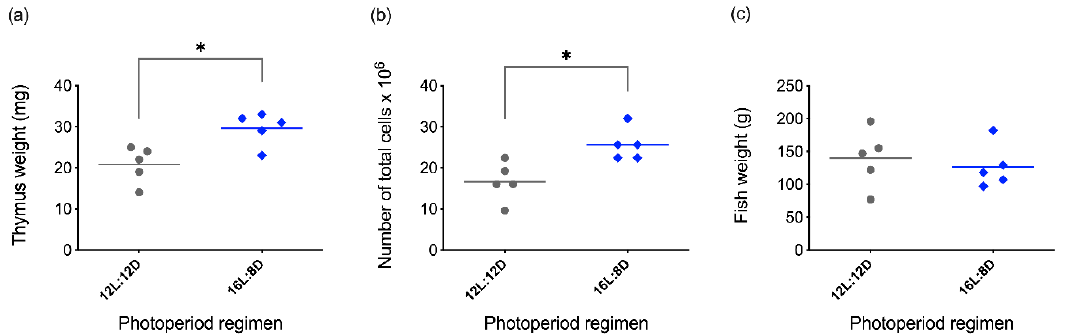
Figure 4. Effect of two different photoperiodic regimes on rainbow trout thymus. ( a ) Thymus weight; ( b ) total cell count of thymus; ( c ) weight of fish used for the experiment. The values are expressed as means ± SEM; n = 5. The statistical test used was Mann-Whitney, with p ≤ 0.05 considered significant. Statistical differences are represented by asterisks.